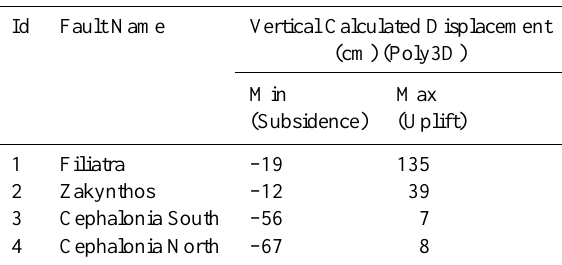
Table 3. Sea bottom deformations due to the activation of the four potential